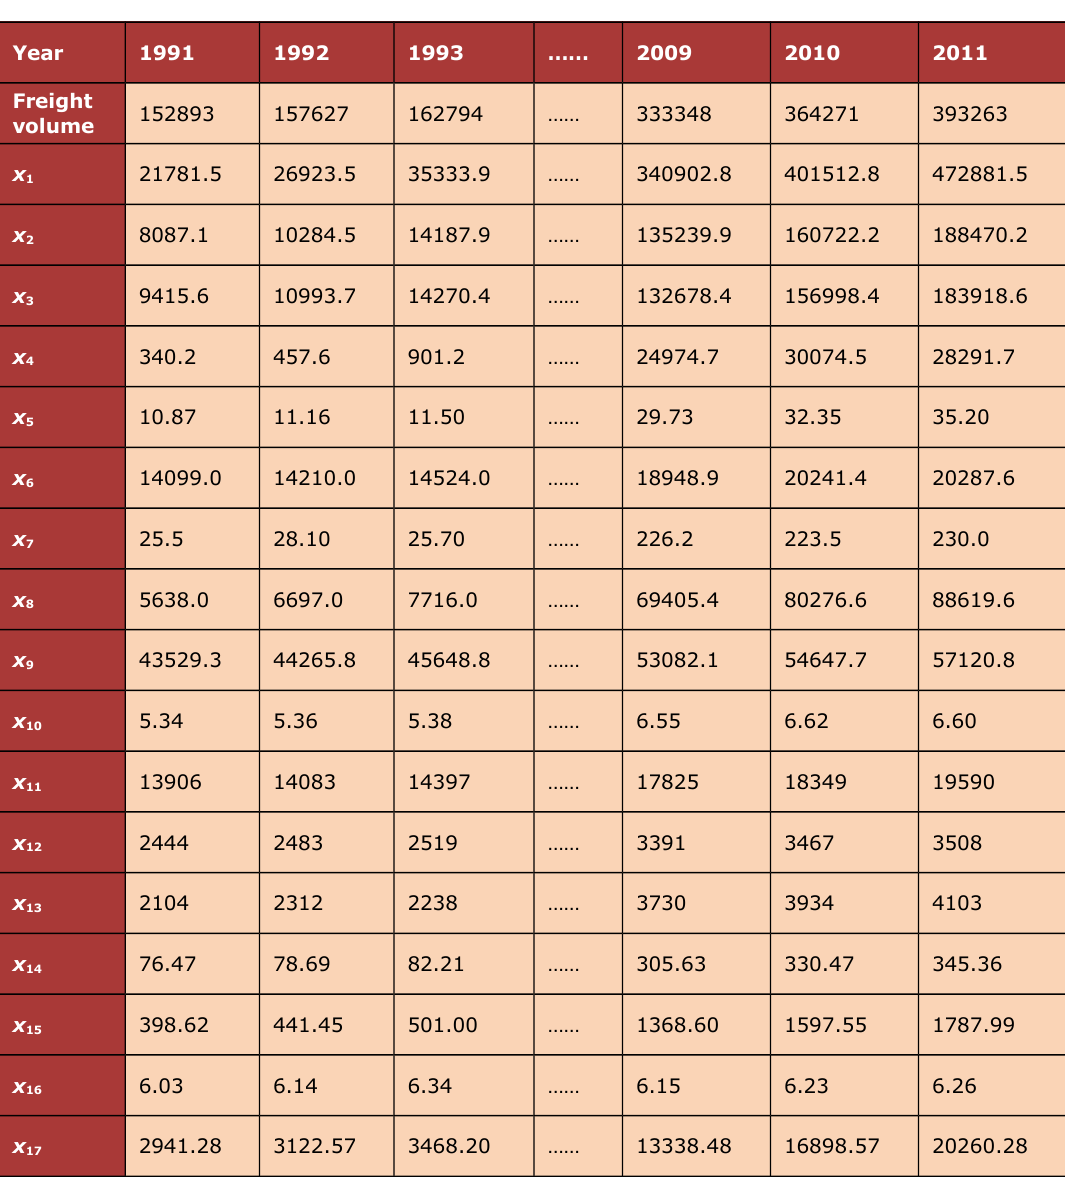
Table 2. Railway freight volume and initial data of railway freight volume prediction